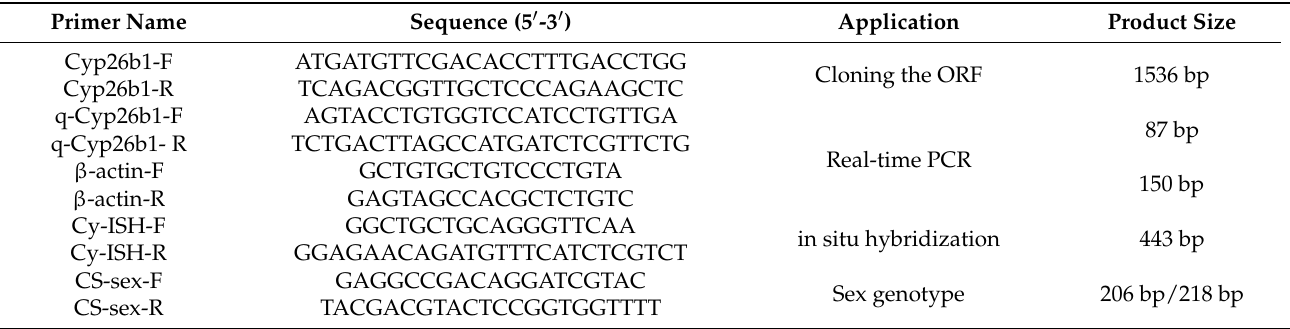
Table 2. Primer sequences used in this